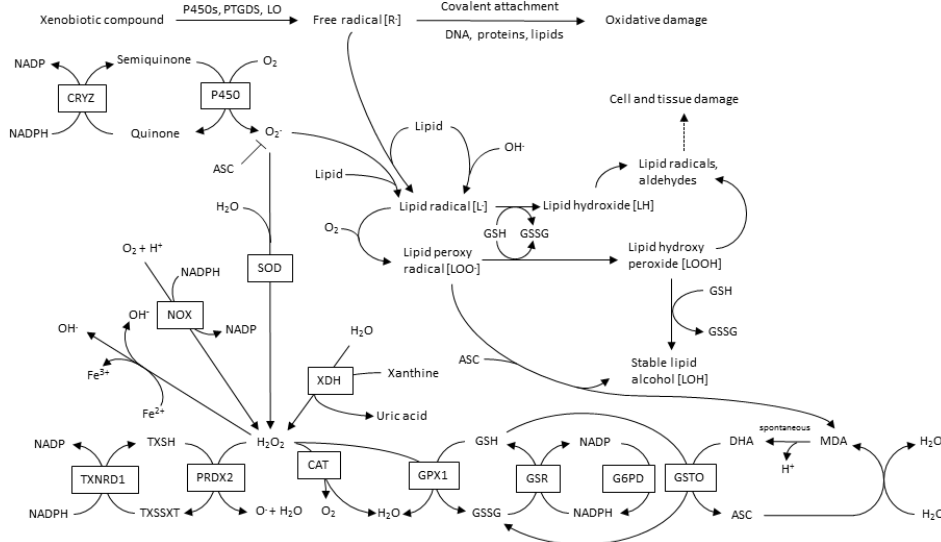
Figure 2. Metabolic pathways in ROS production and metabolism.